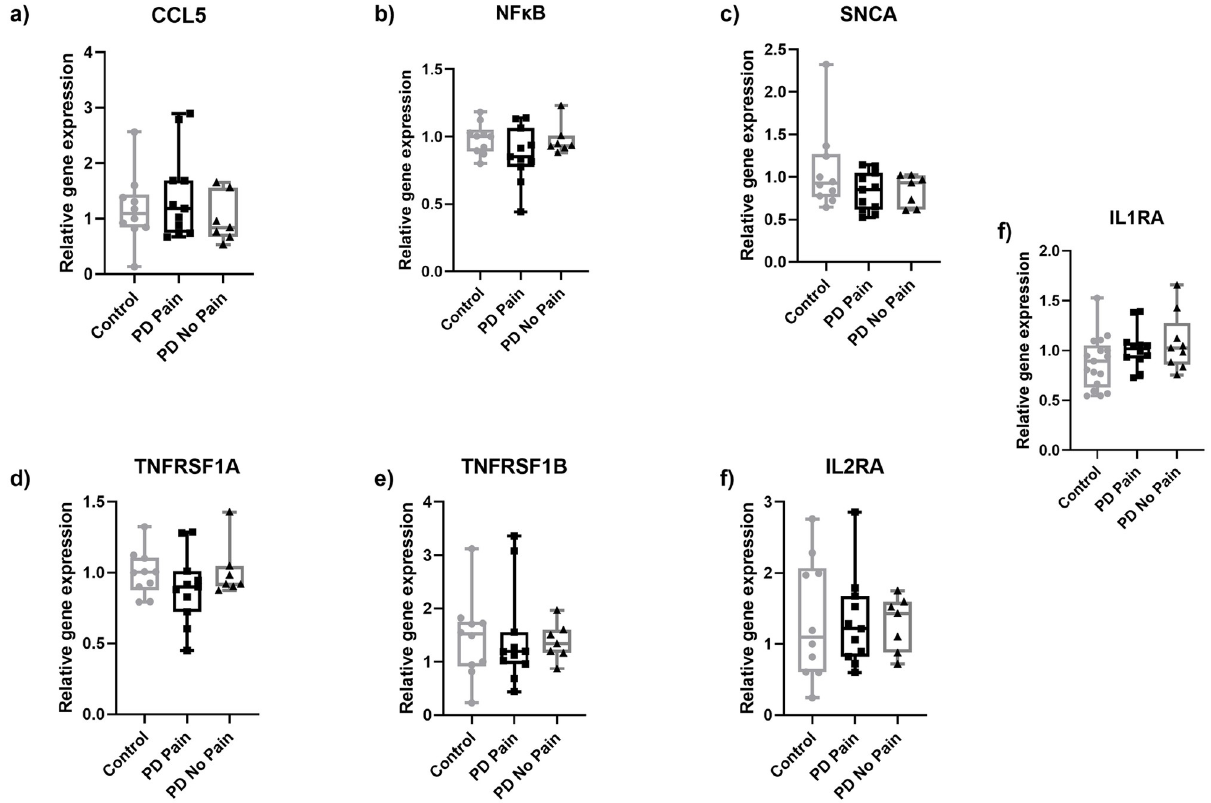
Fig 5. Gene expression of inflammatory mediators in PD Pain skin punch biopsies obtained from the lateral lower leg. No changes in in the expression of CCL5 (a), NF κ B (b), SNCA (c), TNFRSF1A (d), TNFRSF1B (e), IL2RA (f), and IL1RA (g) in PD with pain skin biopsies compared to healthy controls. Data are expressed as median ± range. Abbreviations: CCL5 = C-C chemokine ligand 5, IL2RA = interleukin 2 receptor A, NF κ B = nuclear factor kappa B, PD = Parkinson’s disease, SNCA = synuclein alpha, TNFRSF1A = TNF receptor superfamily member 1A, TNFRSF1B = TNF receptor superfamily member 1B. Kruskal Wallis followed by Dunn’s multiple